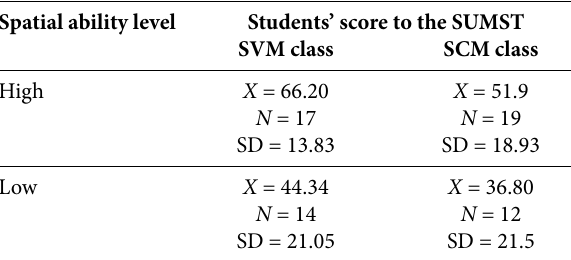
Table 2. Students’ Responses to the SUMST and spatial ability level